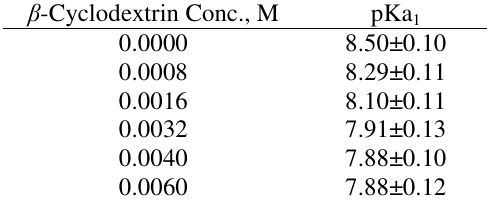
Table 1. Acidity constants of C at 25 ºC and constant ionic strength (0.1 M KNO